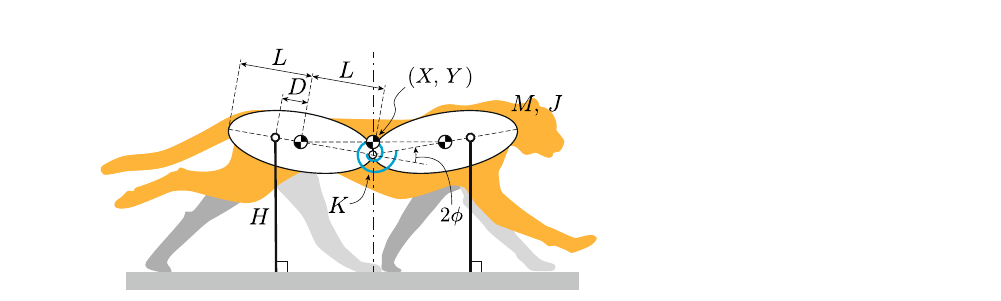
Figure 2. Model comprising two rigid bodies and two massless bars. The bodies are connected by a joint with a torsional spring. The bars represent the